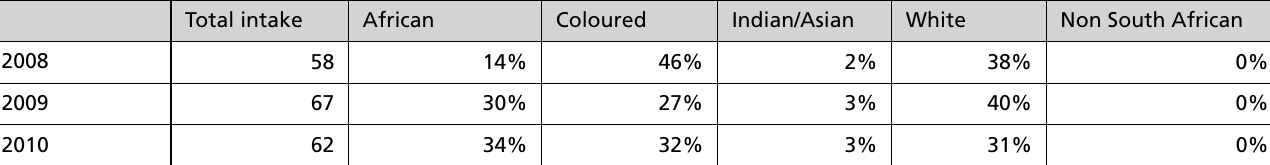
Table 5: Profile of 1 st year undergraduate physiotherapy students in the University of Cape Town (2008-2010) total